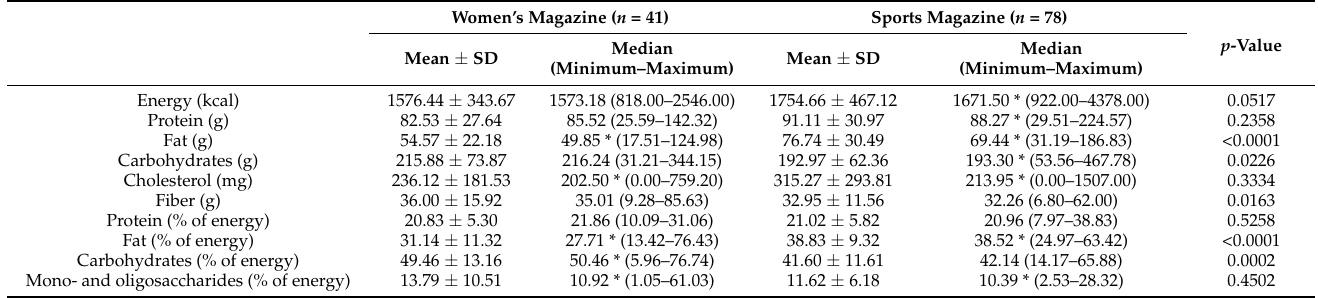
Table 1. The energy value and macronutrient intake within the assessed single-day menus, stratified by type of magazine, for the diets published in the women’s magazine and the diets published in the sports